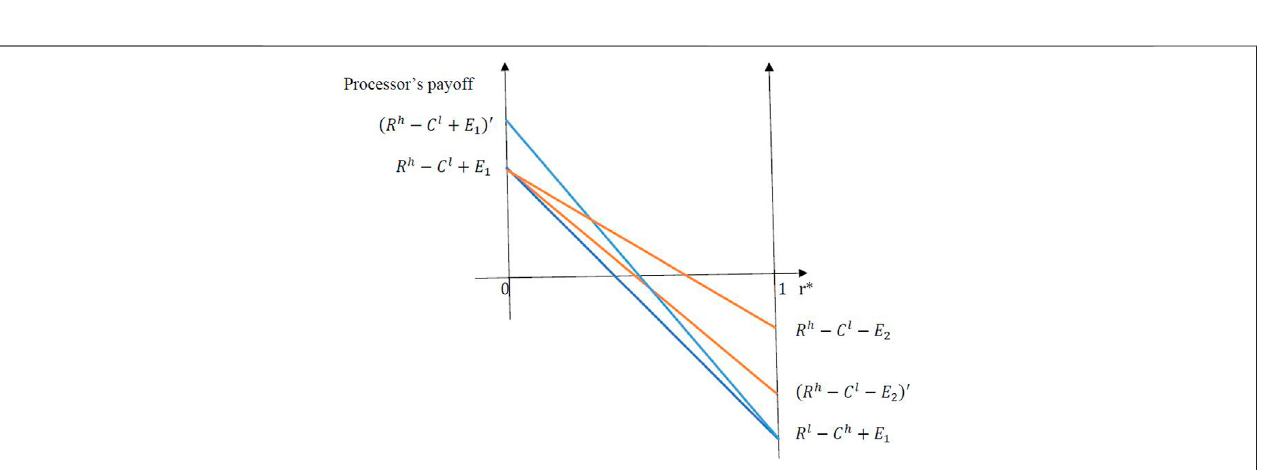
FIGURE 1 | Relationship between the government ’ s payoff and the probability of producing inferior cooking oil.